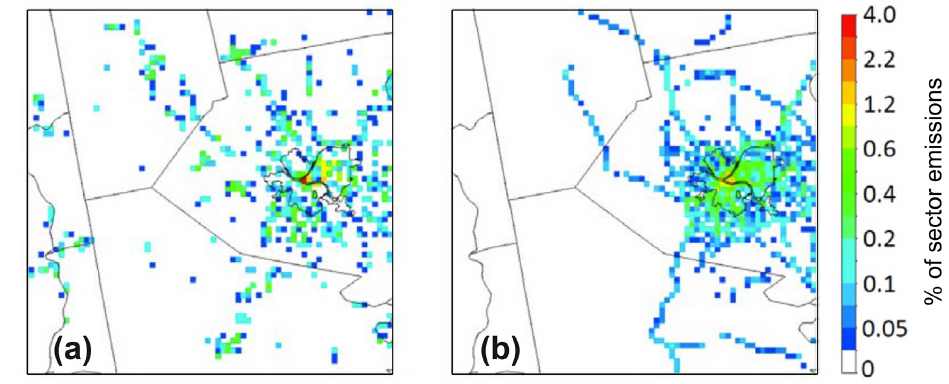
Figure 2. Percentage of sector PM 2 . 5 emissions in each 1 × 1km computational cell for (a) commercial cooking and (b) on-road traffic in February 2017. The value of the colored points in each map add up to unity, corresponding to 100% of emissions for the respective sector.